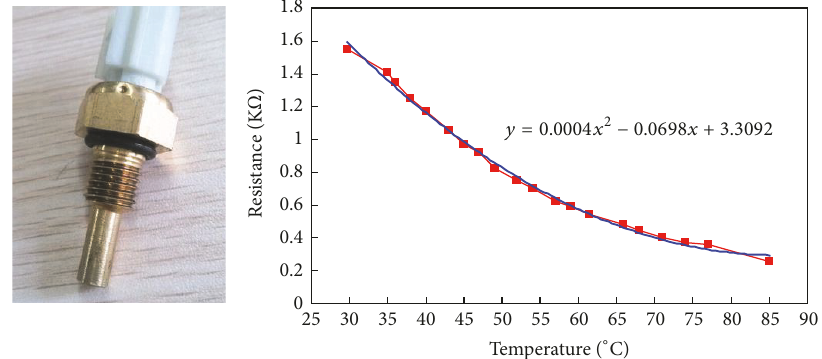
Figure 6: The temperature sensor and electrical characteristic.